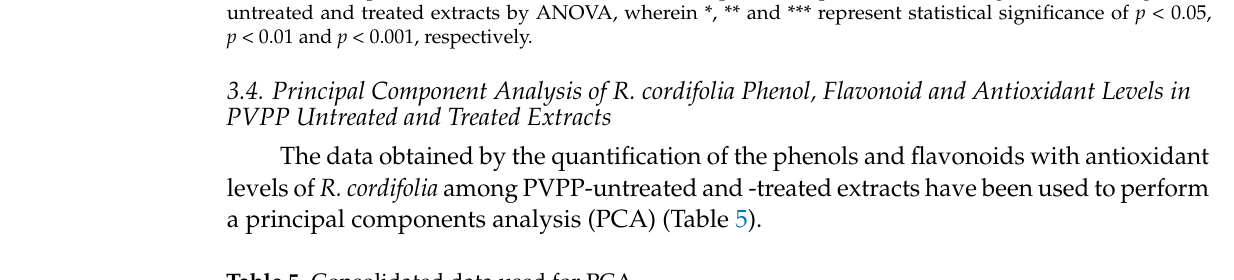
Table 5. Consolidated data used for